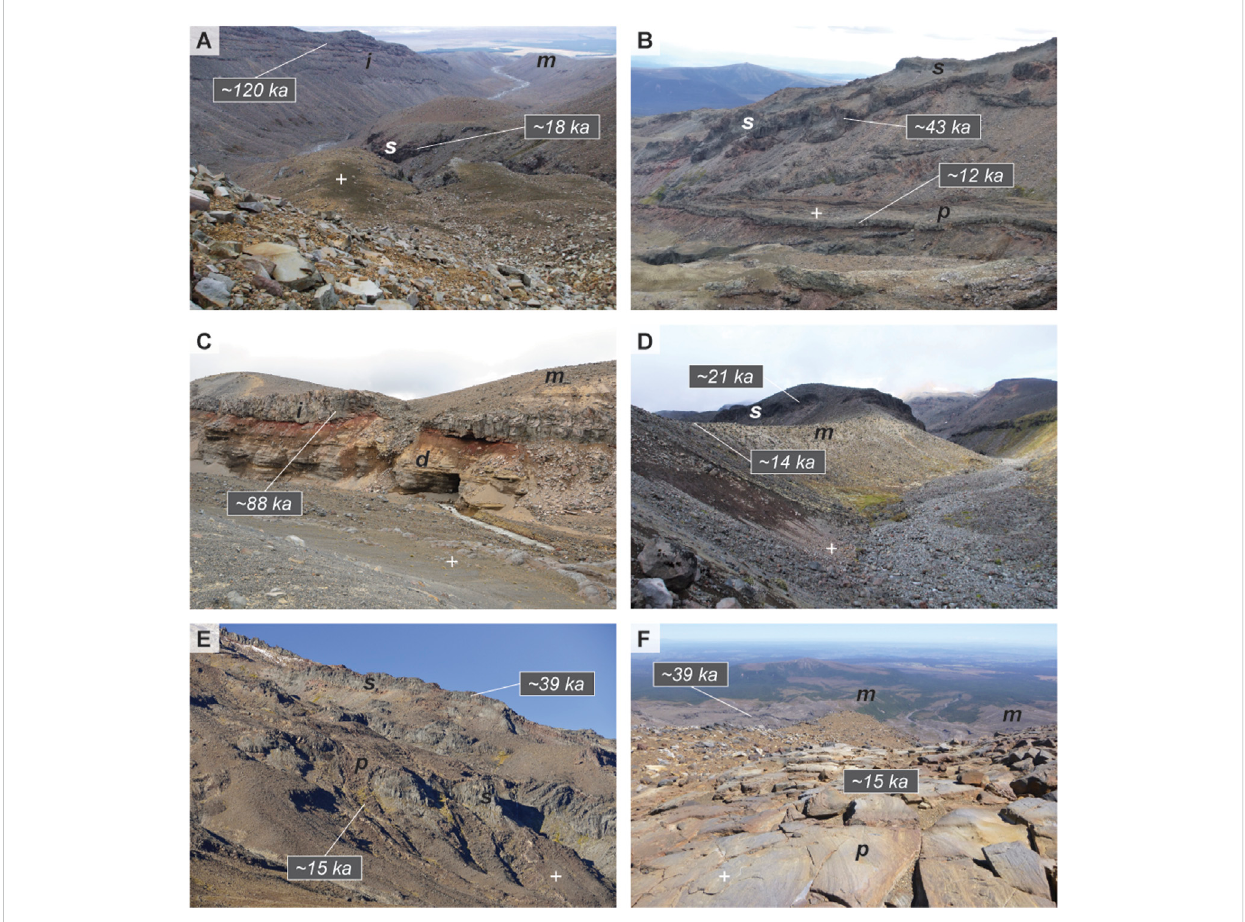
FIGURE 4 Examples of glaciovolcanic landforms at Ruapehu, New Zealand. Lava age constraints are from Gamble et al. (2003) and Conway et al. (2016); moraine age constraint in (D) is from Eaves et al. (2019). Key labelled features are: interglacial lava (i); syn-glacial lava (s); post-glacial lava (p); debris fl ow deposits (d); moraine (m). Location markers for photos (+) are given in degree decimals for each panel. (A) View towards the southeast down the Wahianoa valley, with MIS 5 interglacial stage lavas exposed on the top left and LGM moraines visible at top right. A lobe of syn-glacial lava was emplaced in a glacial cavity prior to post-LGM glacial retreat ( − 39.301, 175.590). (B) View to the northwest of ice-bounded syn-glacial lavas and post- glacialvalley- fi llinglavasintheMangatururuvalley( − 39.282,175.534). (C) OutcropofaMIS5interglacialstagelava fl owwithunderlyingbakeddebris fl ow depositsandoverlyingmoraineinthelowerWhangaehuvalley( − 39.287,175.630). (D) Viewtowardsthenortheastofsyn-glaciallavathatwasboundedby an LGM glacier, which later retreated to form ~14 ka moraines in the Mangaehuehu valley ( − 39.317, 175.538). (E) View to the south of the northwest fl ank ofRuapehu volcano.Ice-boundedlavasoutcropasgreybluffs inthecentreofthephoto andalongtheskylineridge,with thinnerred-brown post-glacial lavas that fl owed around them after glaciers had retreated ( − 39.259, 175.533). (F) View towards the northwest with moraines bordering the Whakapapaiti valley in the mid-ground and glacially striated post-glacial lavas on the upper fl ank ( − 39.263,